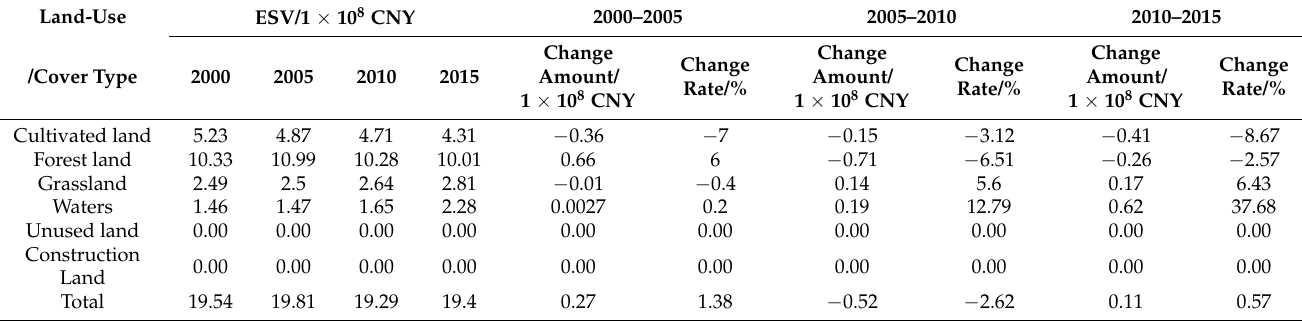
Table 3. Change amount (CNY) and change rate (%) of ecological service value in the Qihe watershed from 2000 to